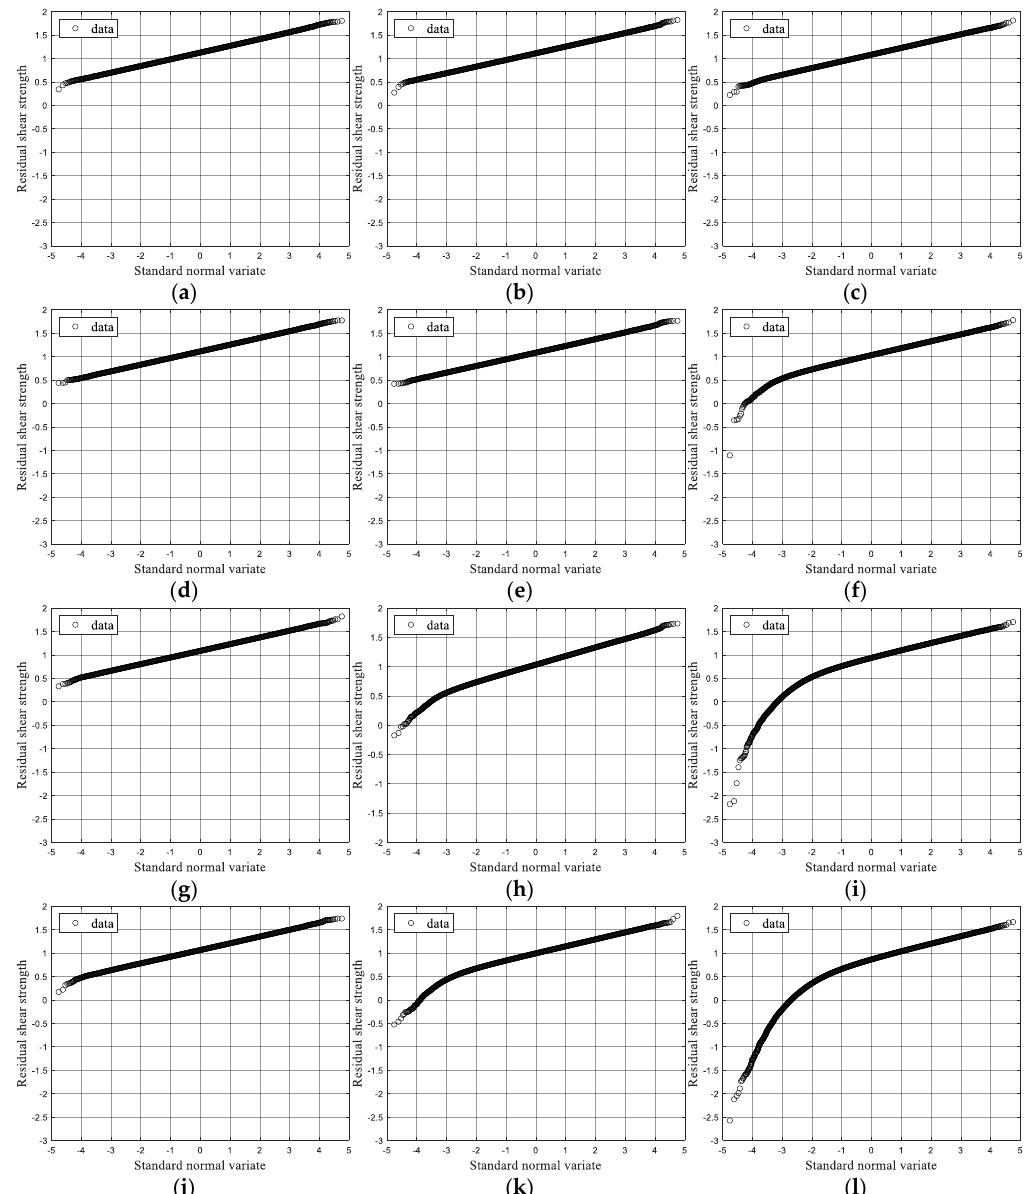
Figure 16. Residual shear strength due to the repeated loads ( 𝑃 𝑢,𝑟 ) on PDF probability paper. ( a ) 785 kN — 25 times; ( b ) 785 kN — 50 times; ( c ) 785 kN — 100 times; ( d ) 1010 kN — 25 times; ( e ) 1010 kN — 50 times; ( f ) 1010 kN — 100 times; ( g ) 1235 kN — 25 times; ( h ) 1235 kN — 50 times; ( i ) 1235 kN — 100 times; ( j ) 1460 kN — 25 times; ( k ) 1460 kN — 50 times; ( l ) 1460 kN — 100 times. Table 22. Bias factor for the shear resistance formula ( 𝑃 𝑢 ) [26]. Case